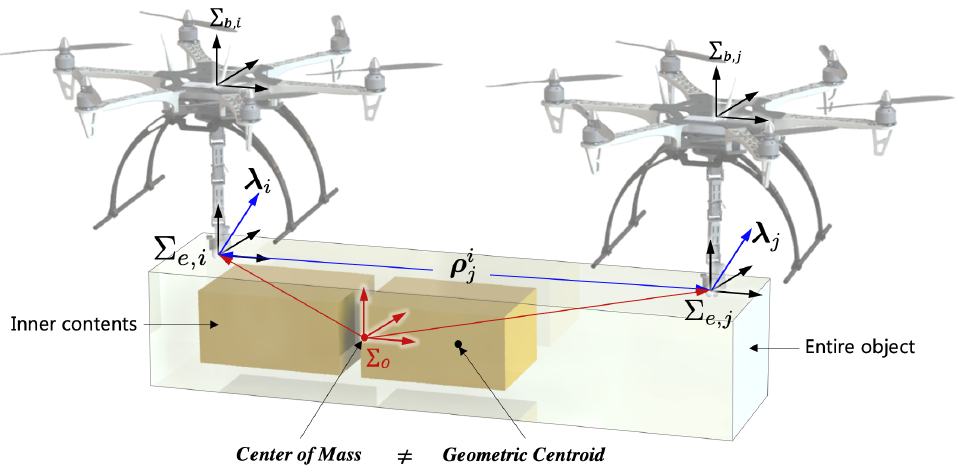
Figure 1. Cooperative flight with a payload with a variable